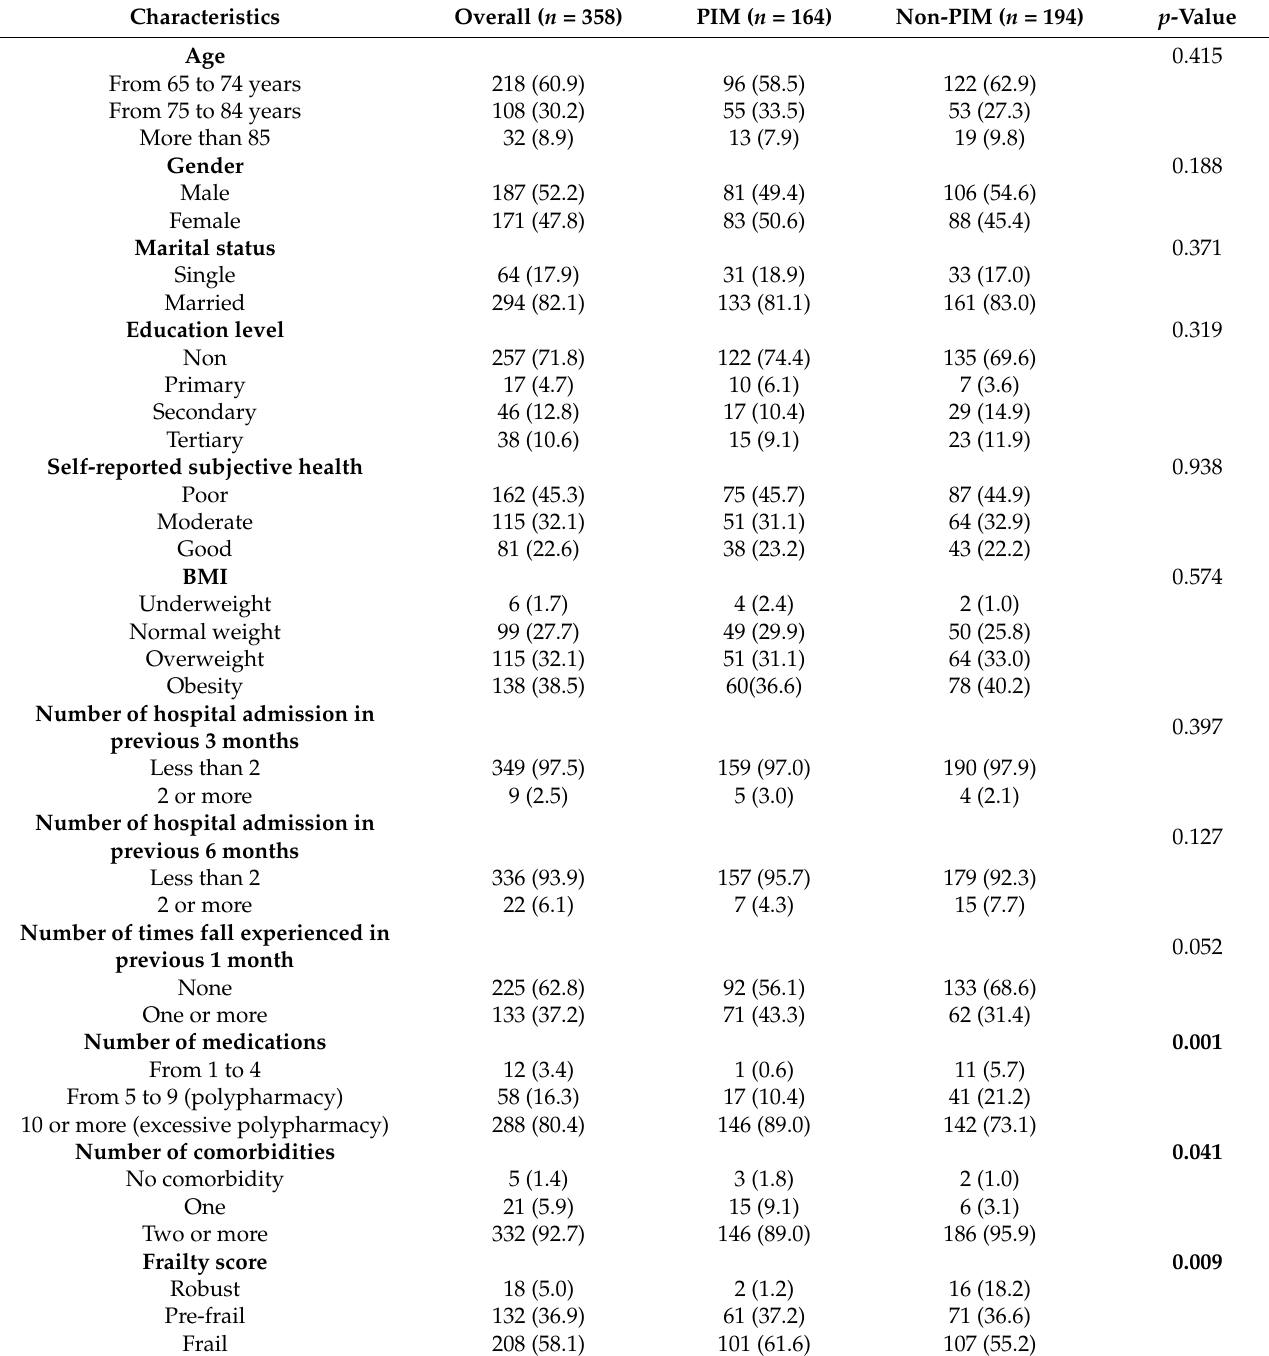
Table 1. Demographic characteristics identified based on the Beers